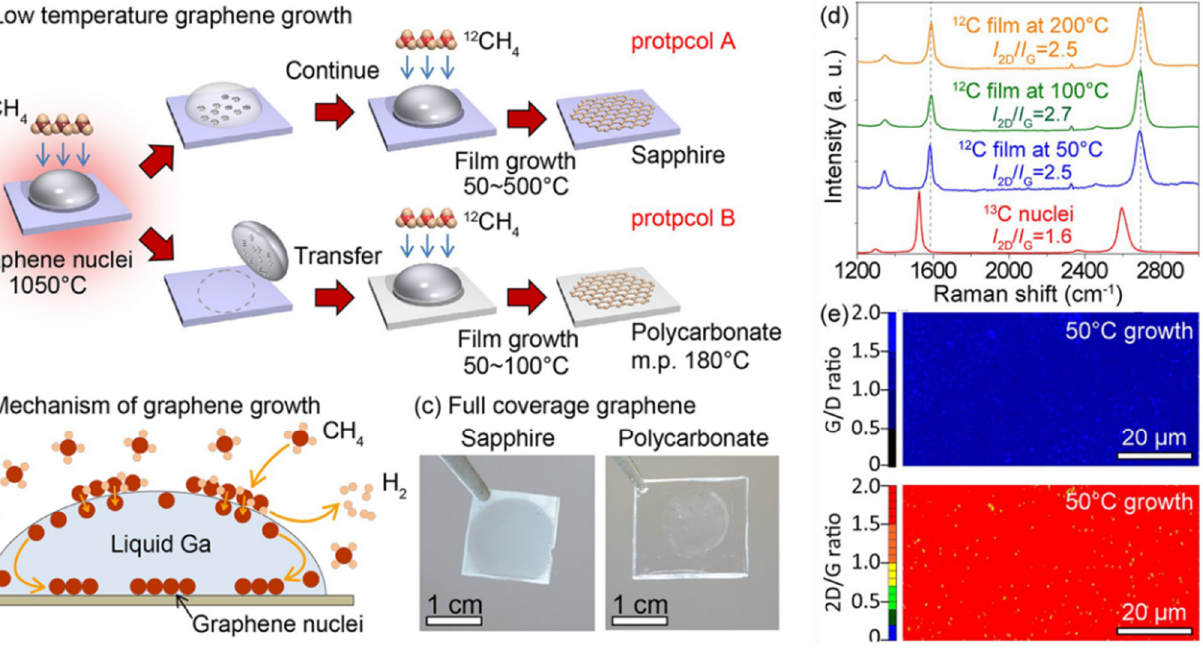
Figure 5. Liquid gallium-catalyzed graphene. ( a ) Schematic diagram of two experiments (A,B) in low temperature; ( b ) Mechanism of graphene nucleation and growth; ( c ) Optical images of graphene films covered on sapphire and polycarbonate substrates; ( d ) Raman spectra of graphene films prepared at 50 °C, 100 °C and 200 °C; ( e ) Intensity ratios of I G /I D and I 2D /I G of samples grown at 50 °C [39].